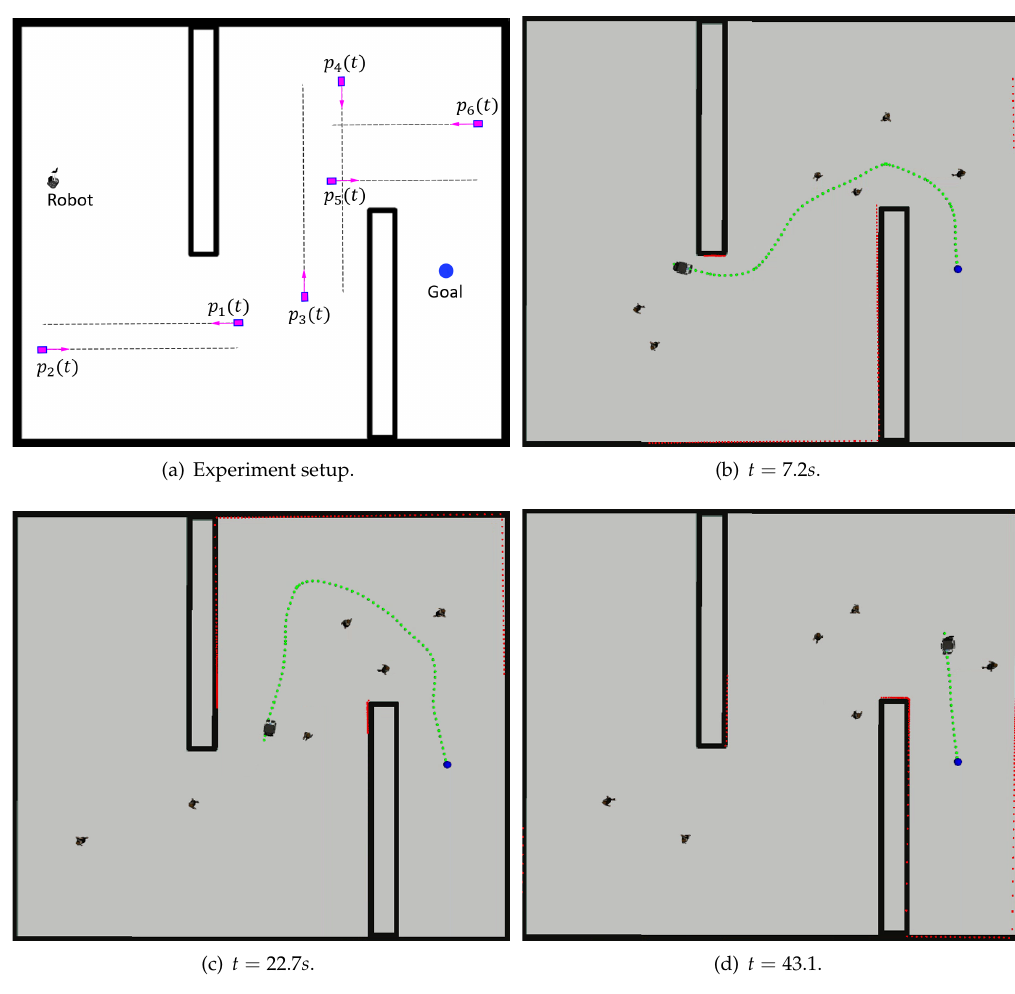
Figure 6. Real-time path planning